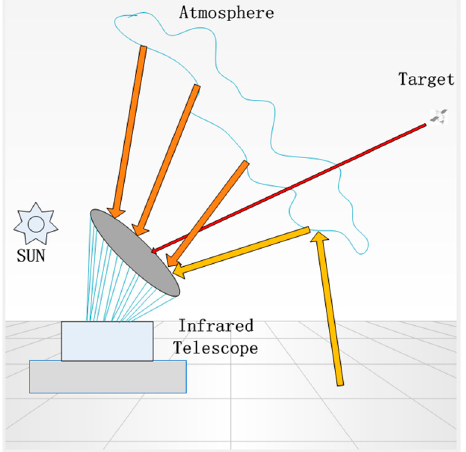
Figure 1. The schematic of infrared telescope detecting the high-orbit target (HOT).